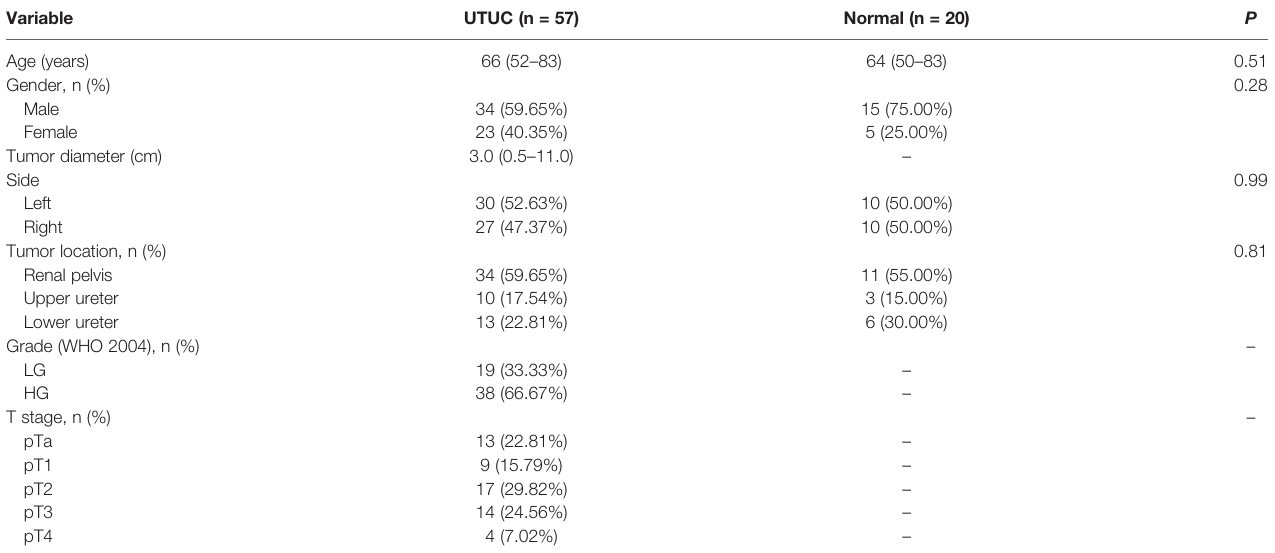
TABLE 1 | Clinical and pathologic information of patients with immunohistochemical staining.